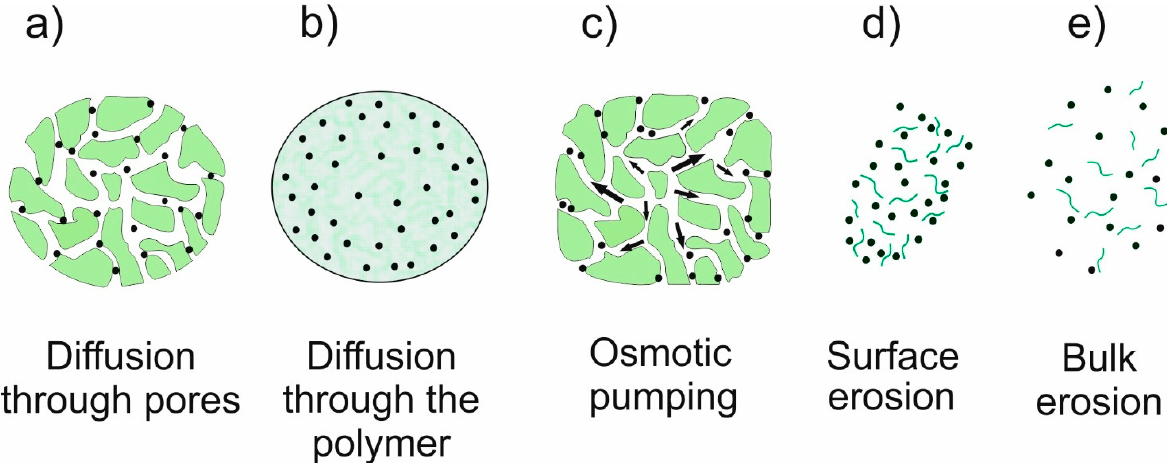
Figure 6. The drug release mechanisms involved in different polymeric drug delivery systems.